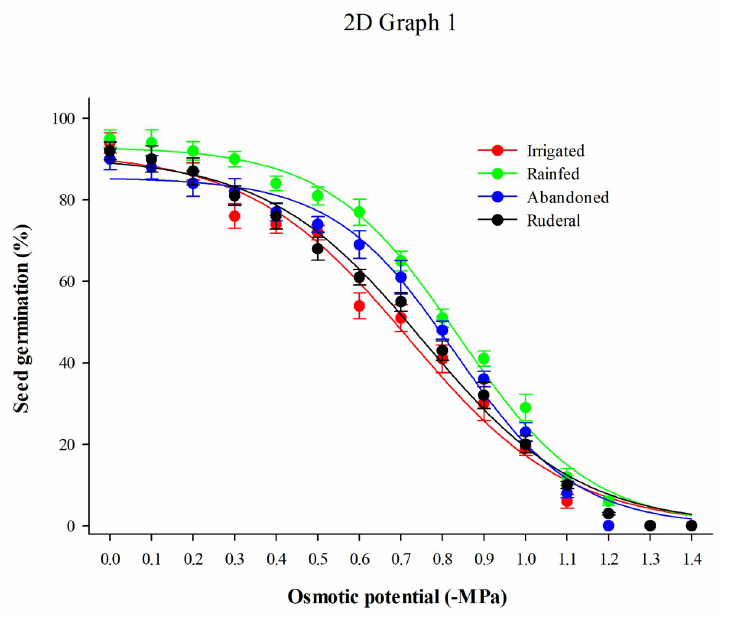
Fig 5. The influence of different osmotic potentials on seed germination of Conyza stricta Willd. The vertical bars present standard errors of means (n = 10).